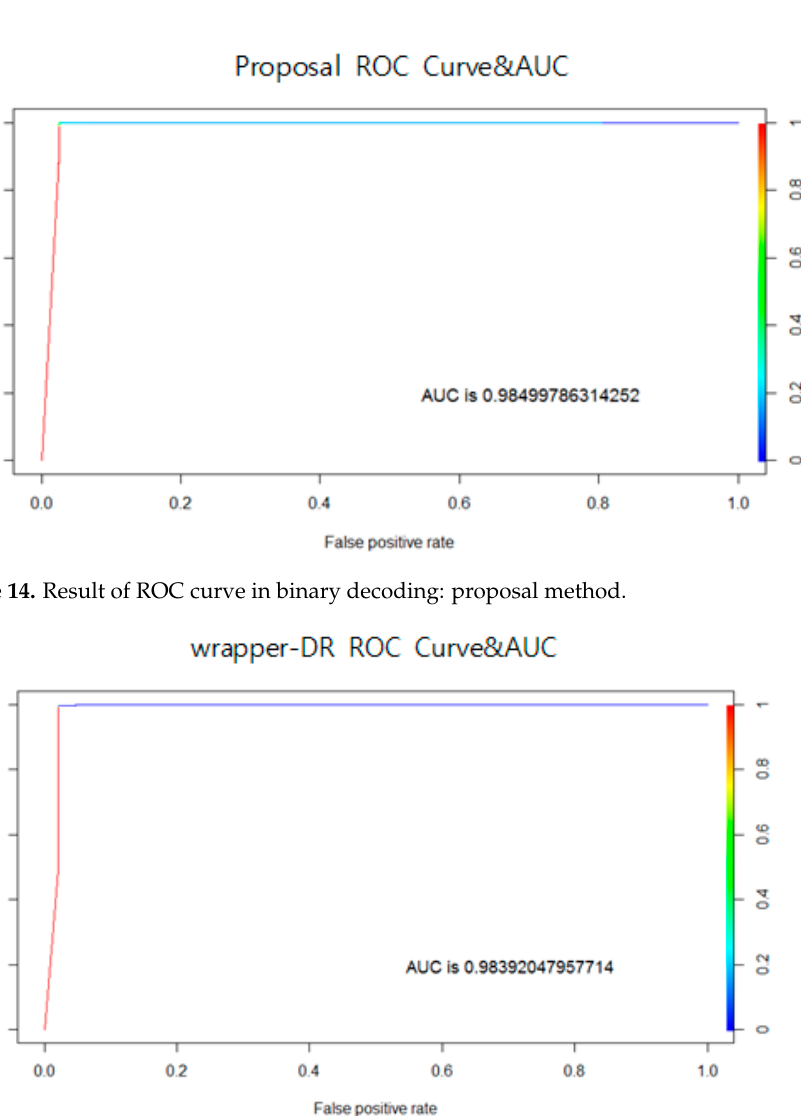
Figure 15. Result of ROC curve in binary decoding: wrapper-DR method.